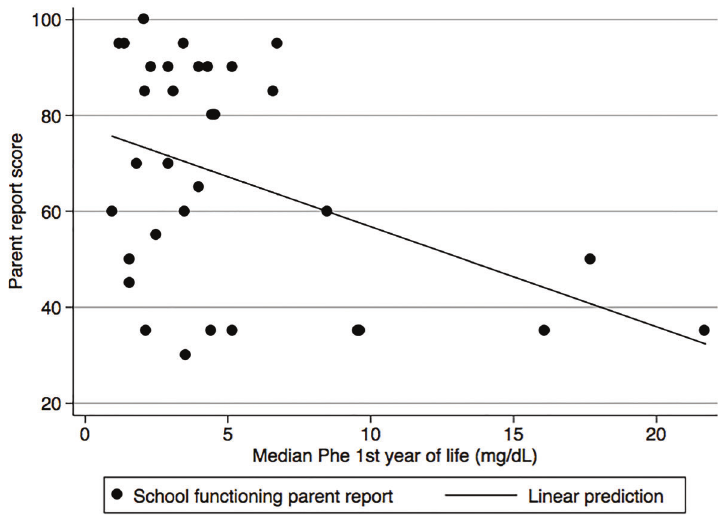
Figure 2. Parent proxy-report school functioning score and median phenylalanine (Phe) levels in the fi rst year of life. A signi fi cant inverse relation- ship between these two variables was found by linear regression analysis (t= – 2.64, P=0.013).